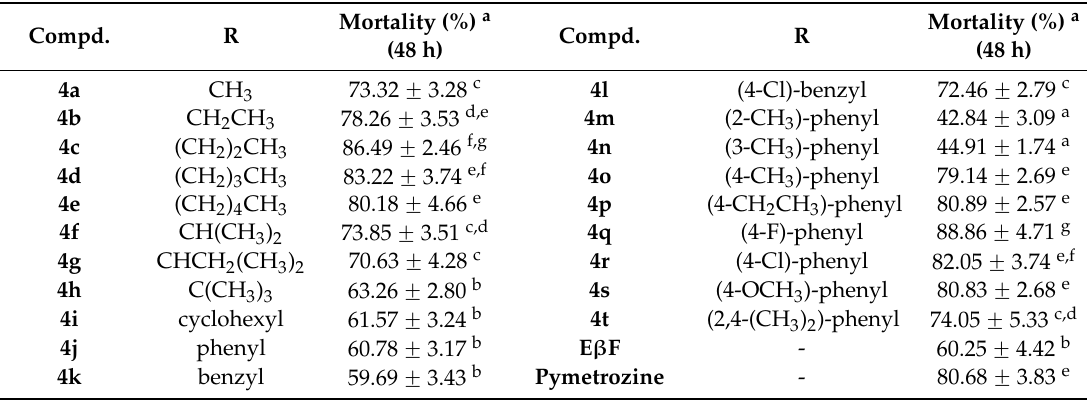
Table 3. Aphicidal activity of the E β F analogues 4a – 4t at 300 µ g/mL.